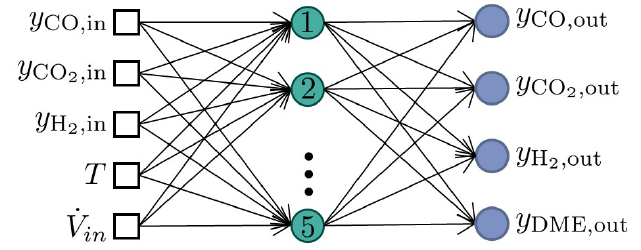
Figure 3. Representation of the data-based model. Adapted from N. Delgado Otalvaro et al.